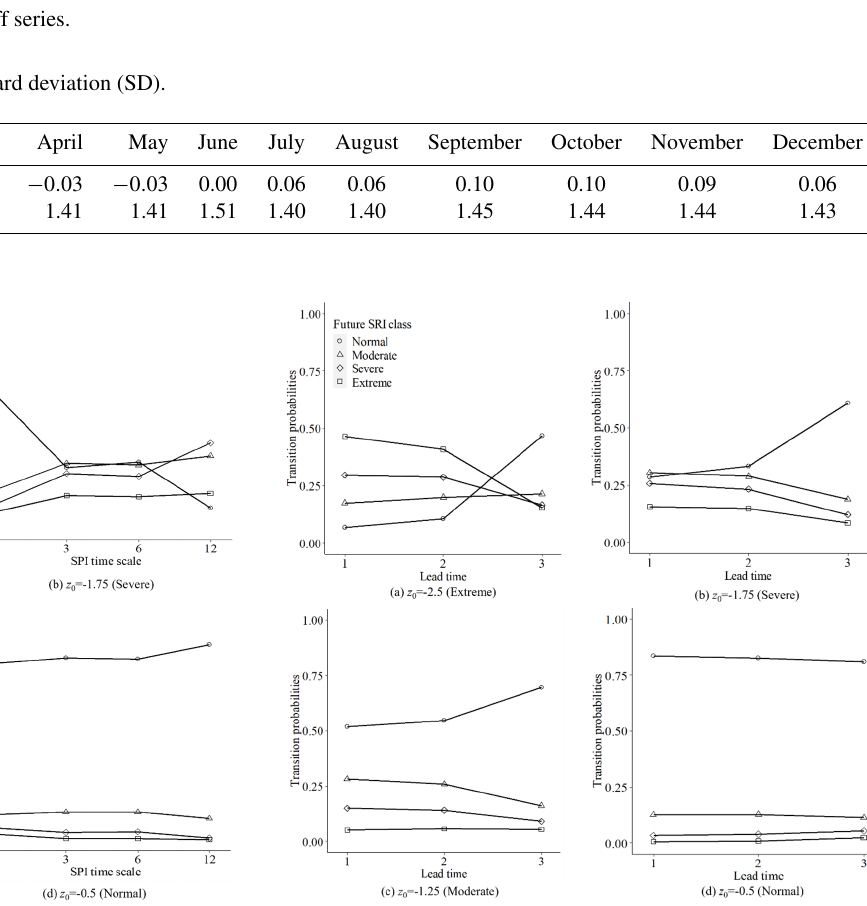
Figure 4. Influence of forecast period on transition probabilities ( z 0 : initial value of